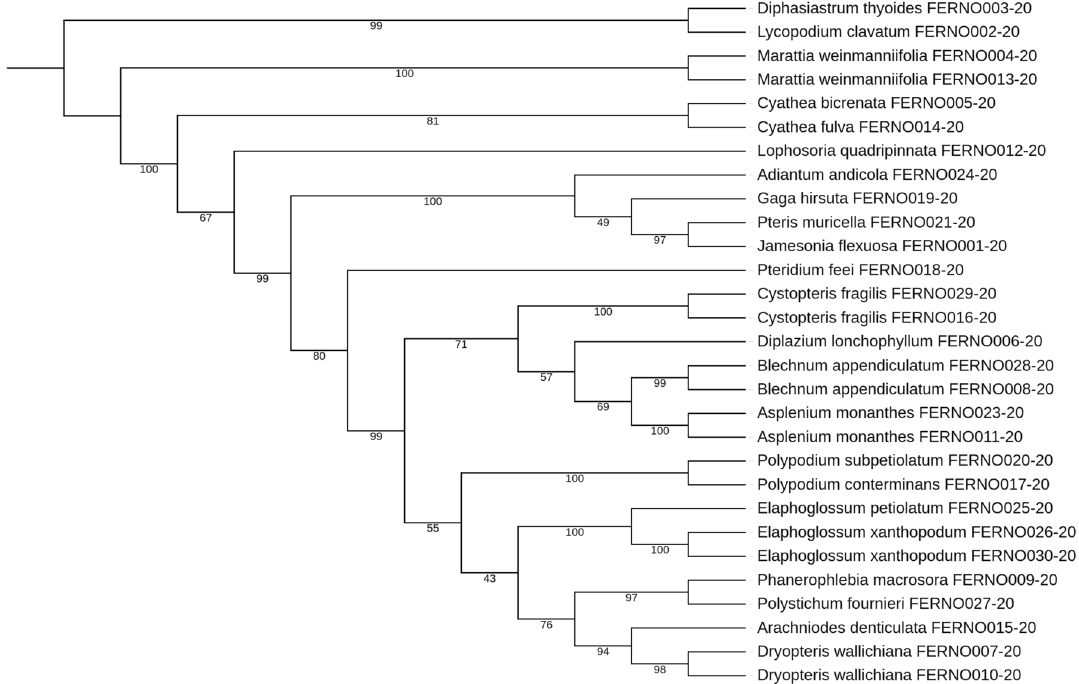
Figure 2. Maximum likelihood cladogram of plastid rbcLa for 27 sequences of ferns and 2 sequences of lycopods from Mixteca Alta, Oaxaca, México, tropical montane cloud forest. Bootstrap values based on 1000 replications are listed as percentages at branching